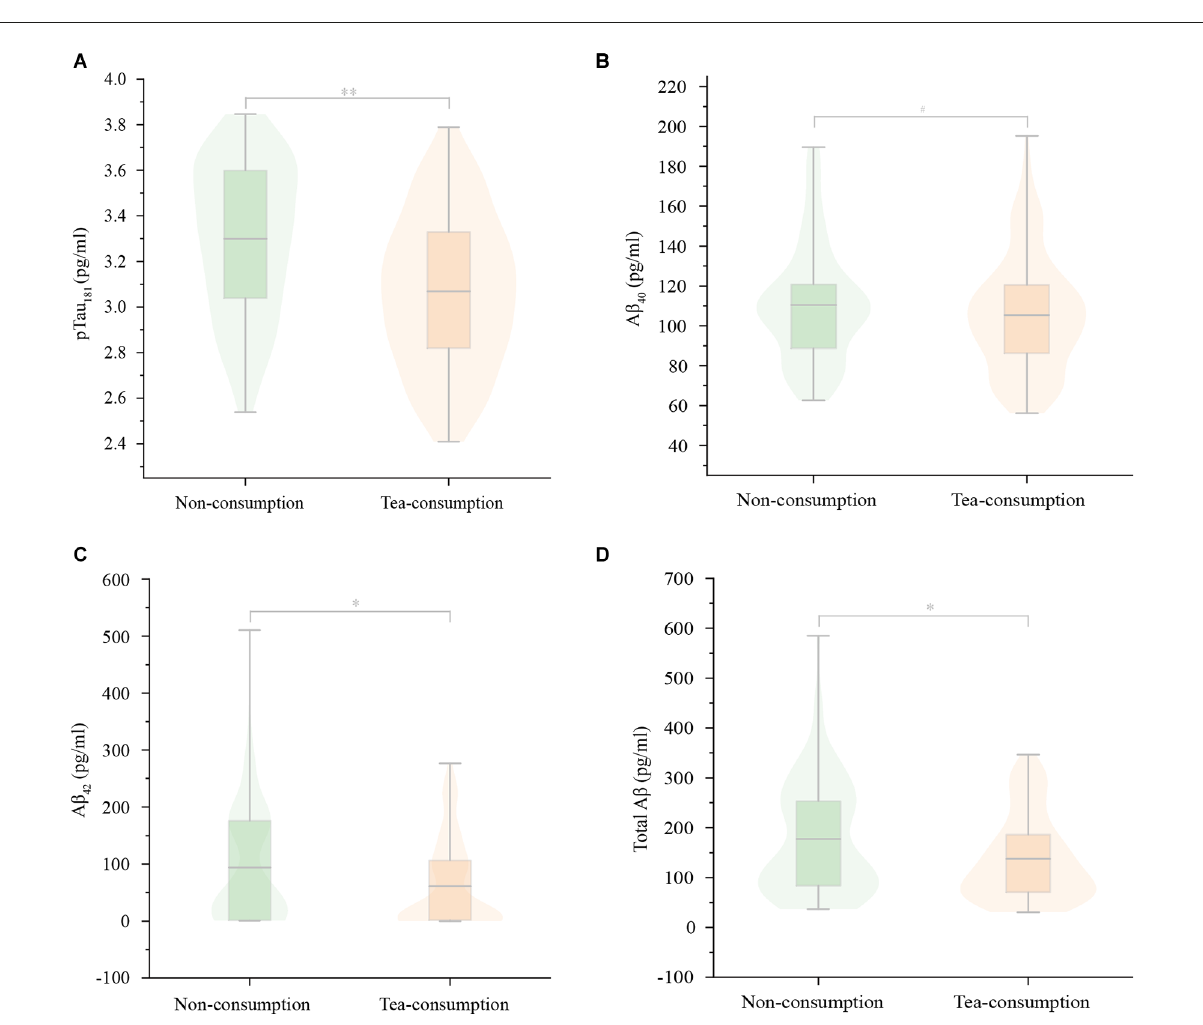
FIGURE5 The differences in serum AD markers between the non-consuming group and the tea-consuming group. There were significant differences in serum pTau181 (A) , A β 42 (C) , and total A β (D) levels between the two groups but no difference in serum A β 40 (B) levels. The serum pTau181, A β 42, and total A β levels were lower in the tea-consuming group. A β , Amyloid- β ; pTau181, phosphorylated tau-181. ∗∗ P < 0.001; ∗ P < 0.05; # P ≥ 0.05.